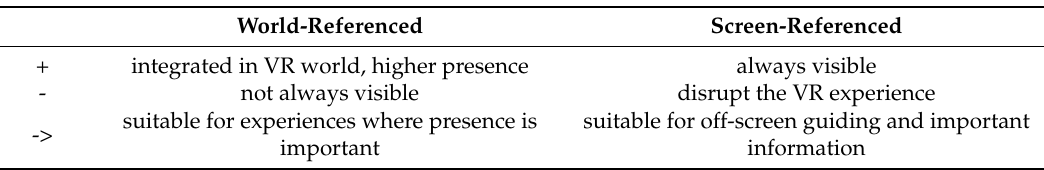
Table 6. Advantages and disadvantages of world-referenced and screen-referenced methods. The third row indicates for which requirements the methods are